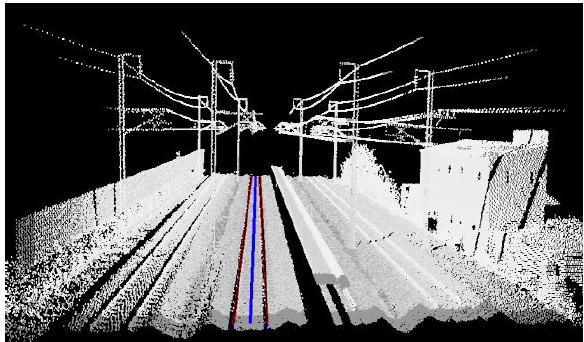
Figure 7. Raw mobile LiDAR data set colorized from black to white w.r.t. the intensity strength of point clouds, and 3D railway track models (red color) and track center line (blue color) in the main track region.